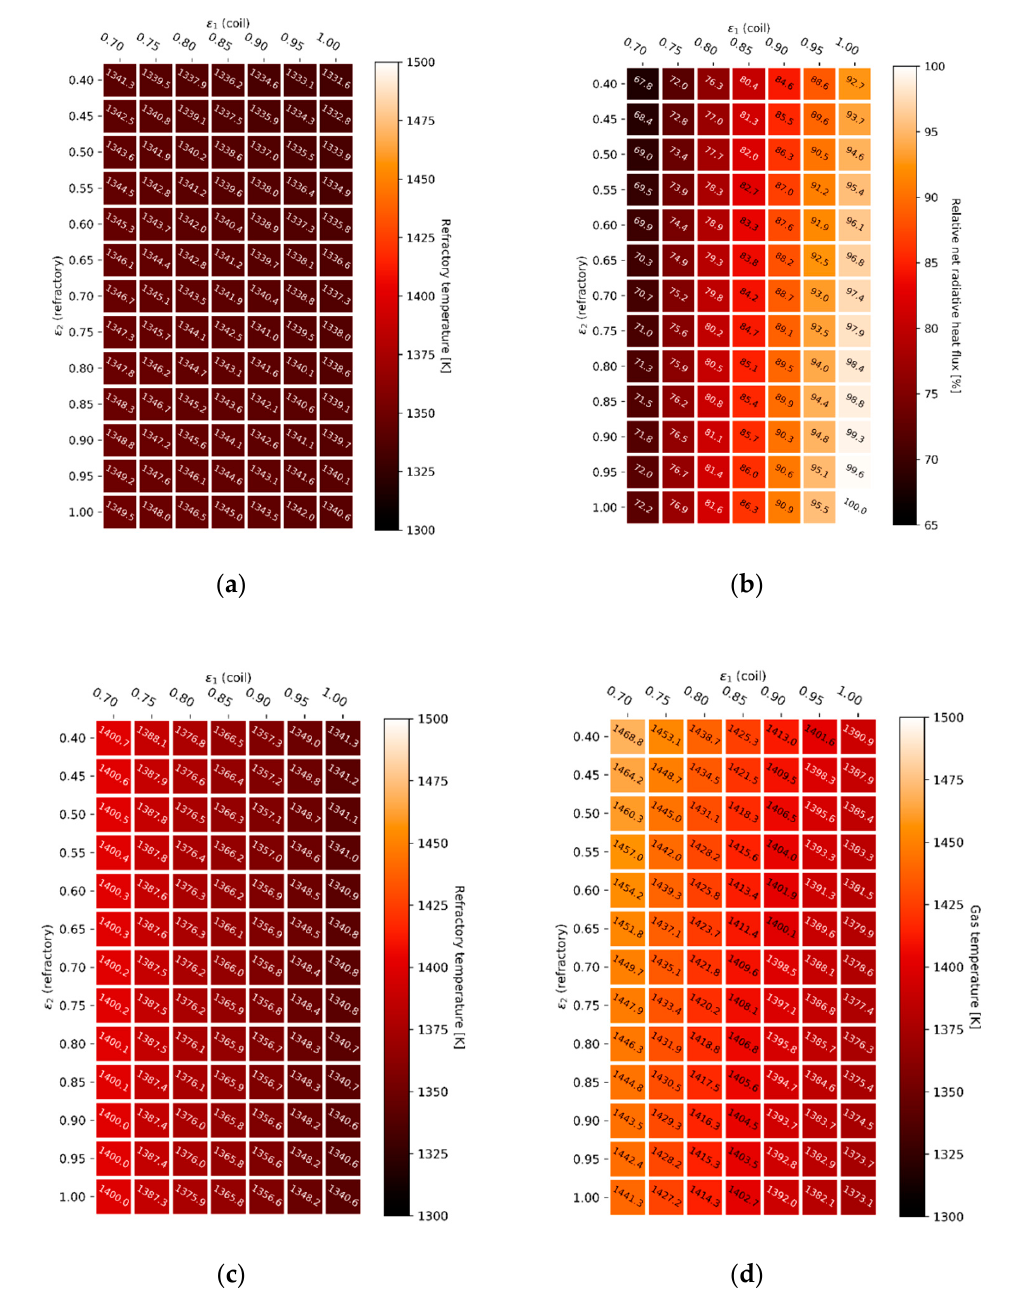
Figure 12. Refractory wall temperature ( a ) and radiative heat flux ( b ) for a constant gas phase temperature. Refractory wall temperature ( c ) and gas phase temperature ( d ) for a constant radiative heat flux in the presence of a gray-plus-clear gas.